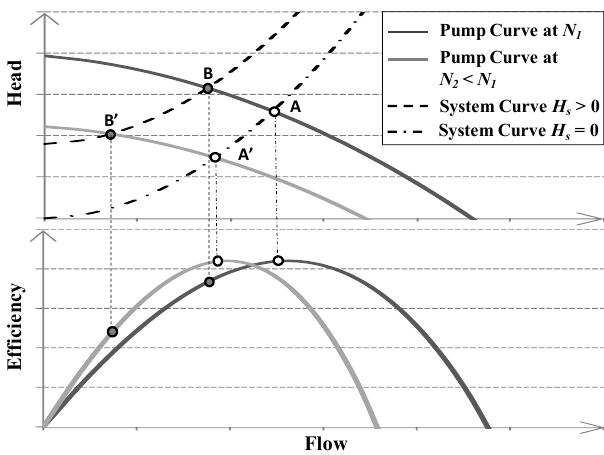
Figure 3. Operating points and e ffi ciencies with varying speeds: in case of system with zero static head, the operating point A at the rotational speed N 1 moves to A 0 when the speed is reduced to N 2 , but A and A 0 maintain the same e ffi ciency; in case of system with considerable static head the operating point at the reduced speed, B 0 , has an e ffi ciency lower than the operating point B at the nominal speed N 1